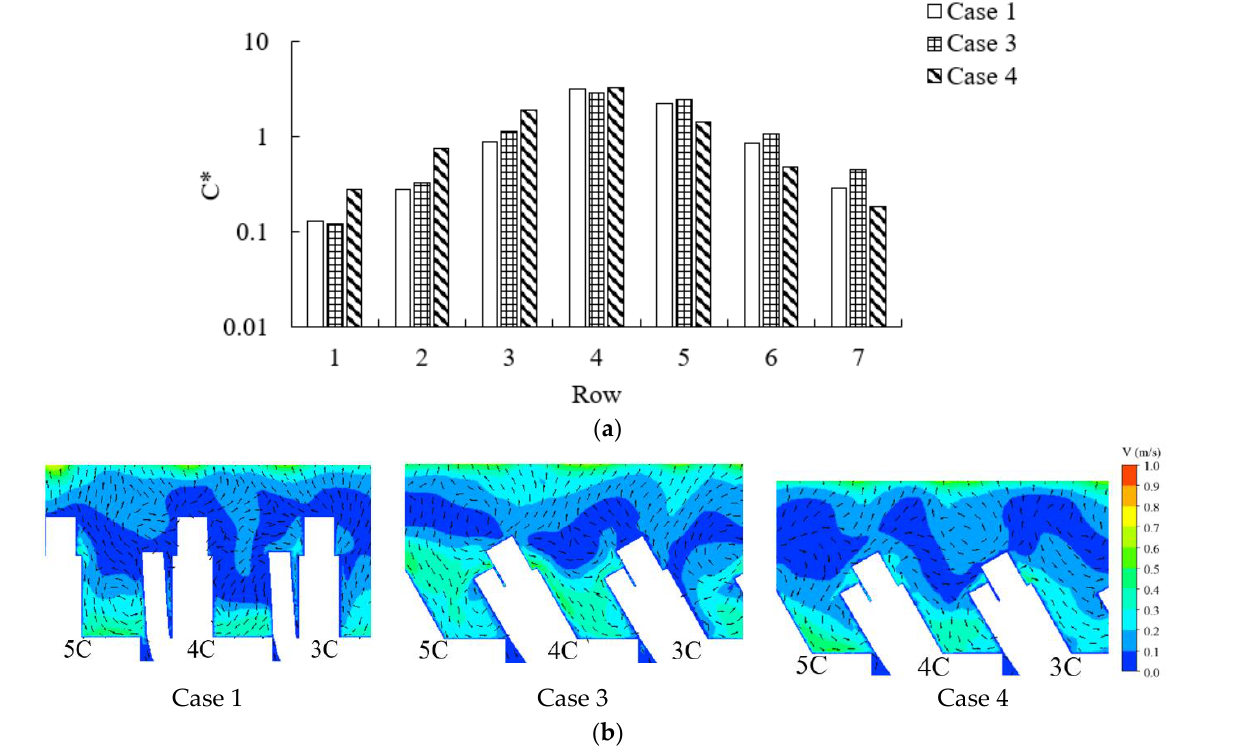
Figure 11. Comparison of normalized pollutant concentration and airflow in Cases 1, 3, and 4: ( a ) average pollutant concentrations in the respiratory zone of the passengers in each row for the pollutant released from 4B, ( b ) airflow distribution in the longitudinal section from 3C to 5C.